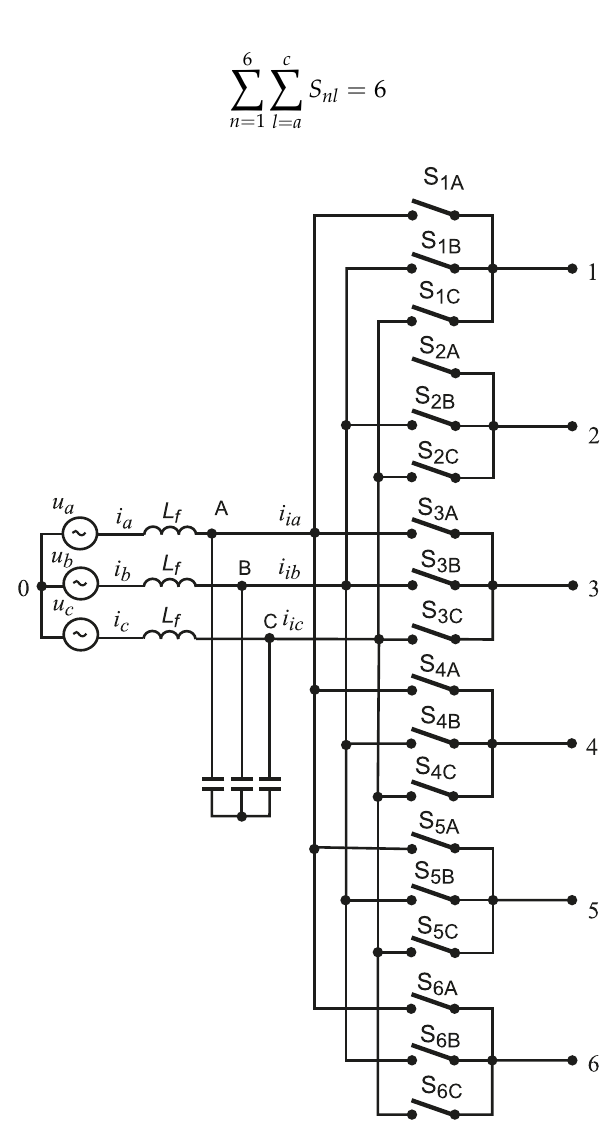
Figure 1. Scheme of three ‐ to ‐ six ‐ phase matrix converter.